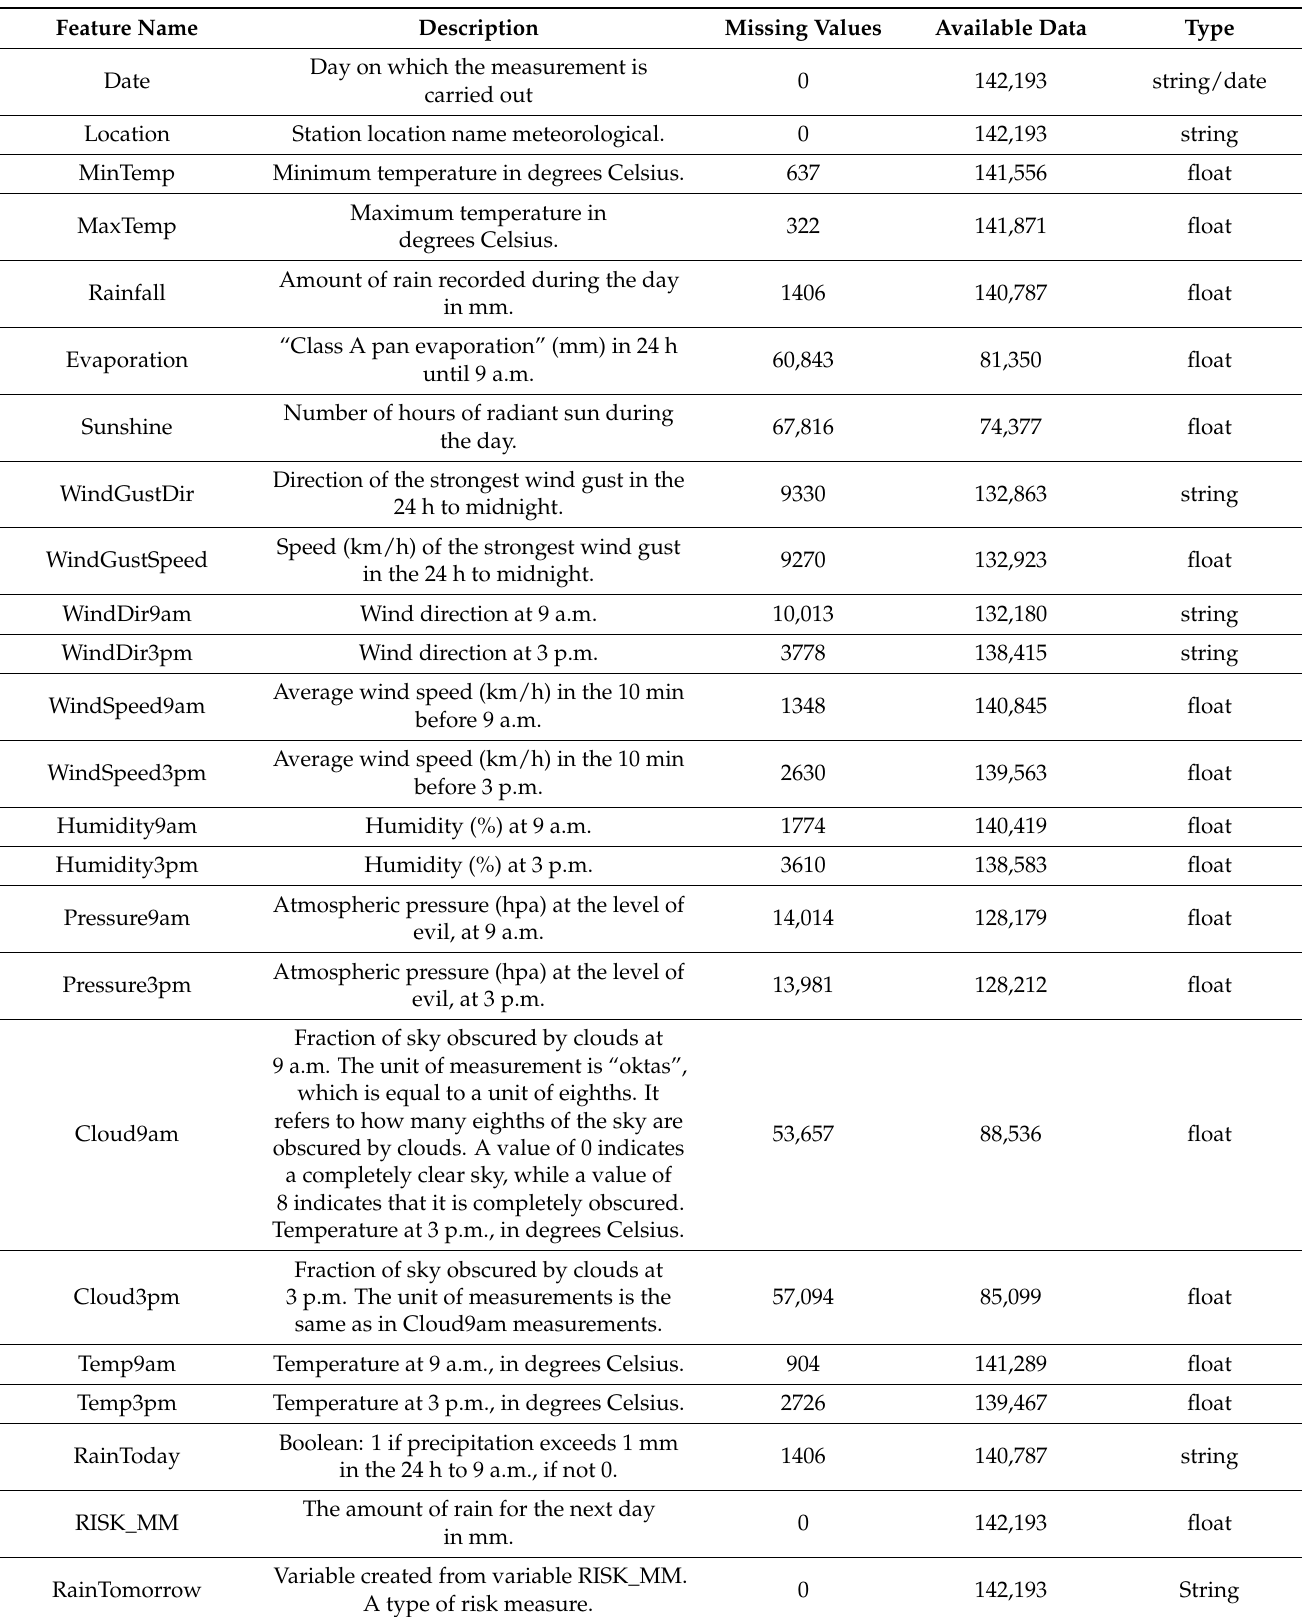
Table 1. Descriptive table of the